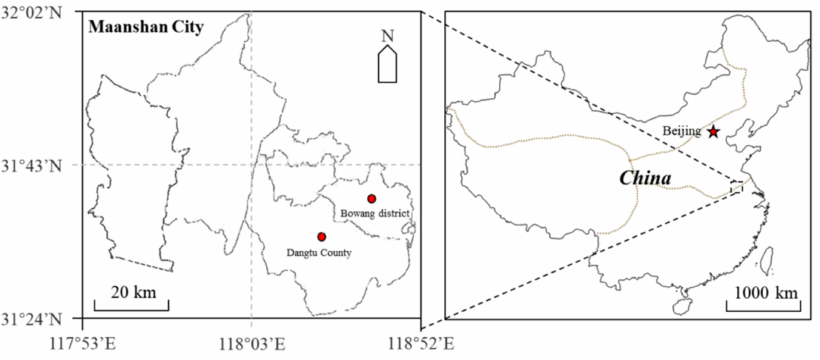
Figure 1. The location map of the study area and sample